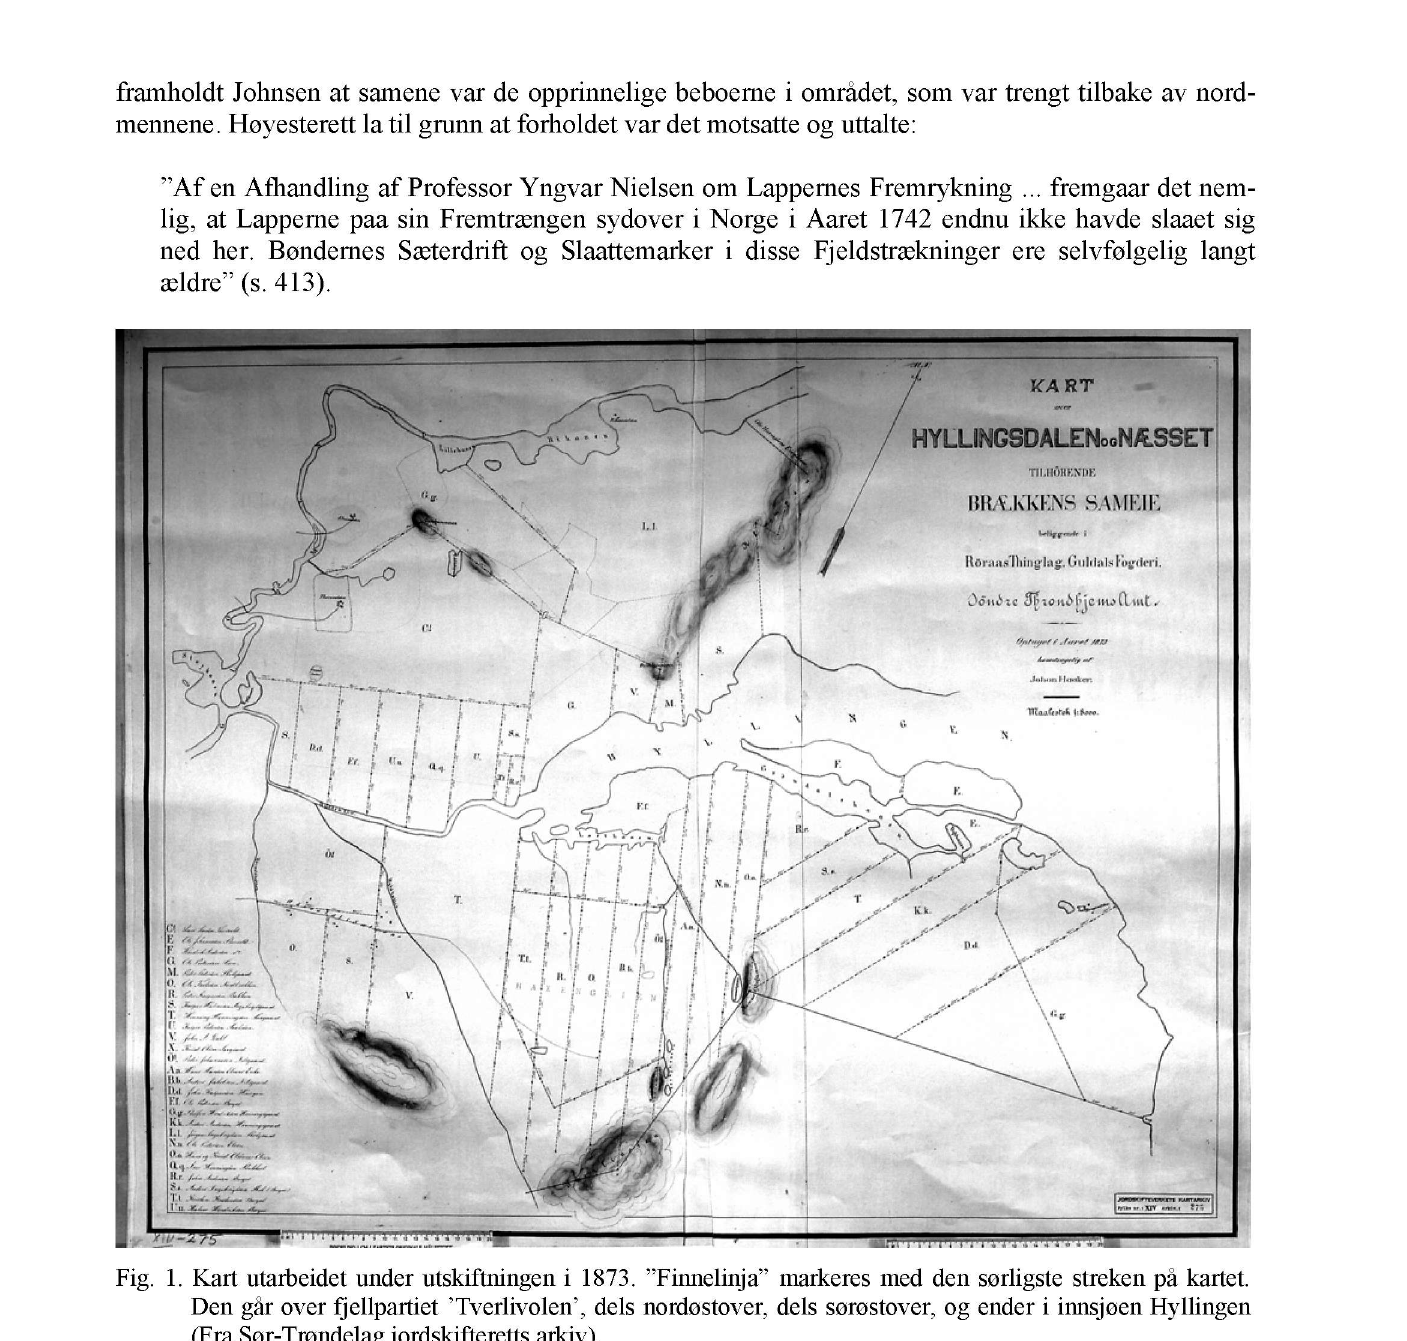
Fig. 1. Kart utarbeidet under utskiftningen i 1873. "Finnelinja" markeres med den sørligste streken på kartet. Den går over fjellpartiet 'Tverlivolen', dels nordøstover, dels sørøstover, og ender i innsjøen Hyllingen (Fra Sør-Trøndelag jordskifteretts